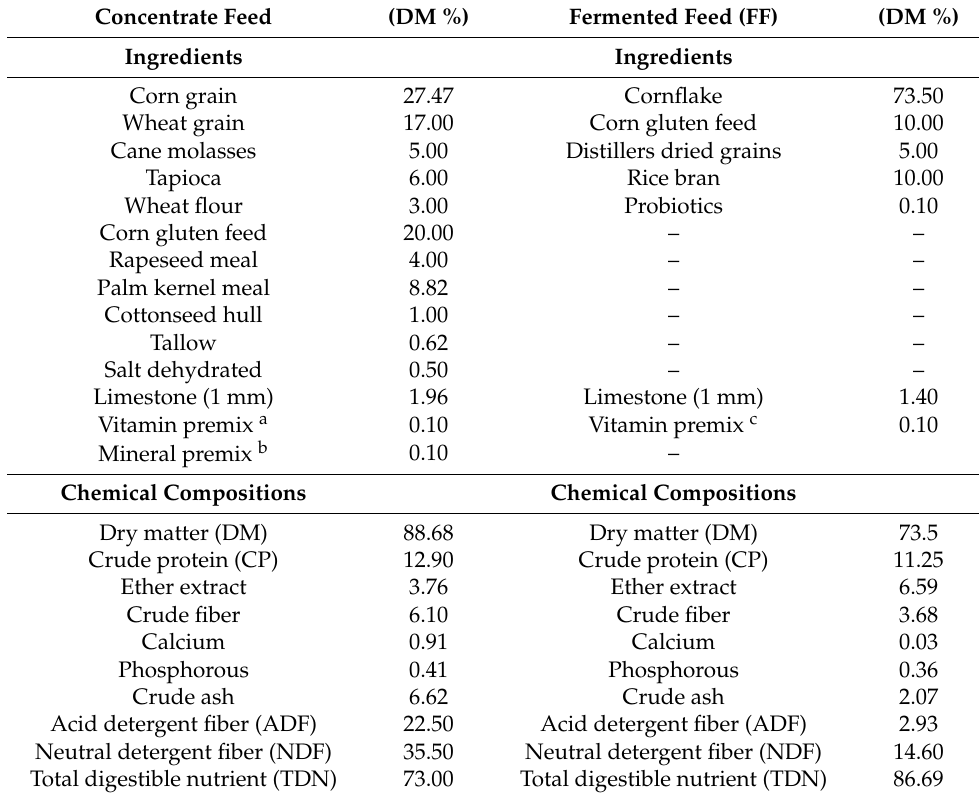
Table 2. Ingredient compositions and chemical analysis of concentrate and fermented